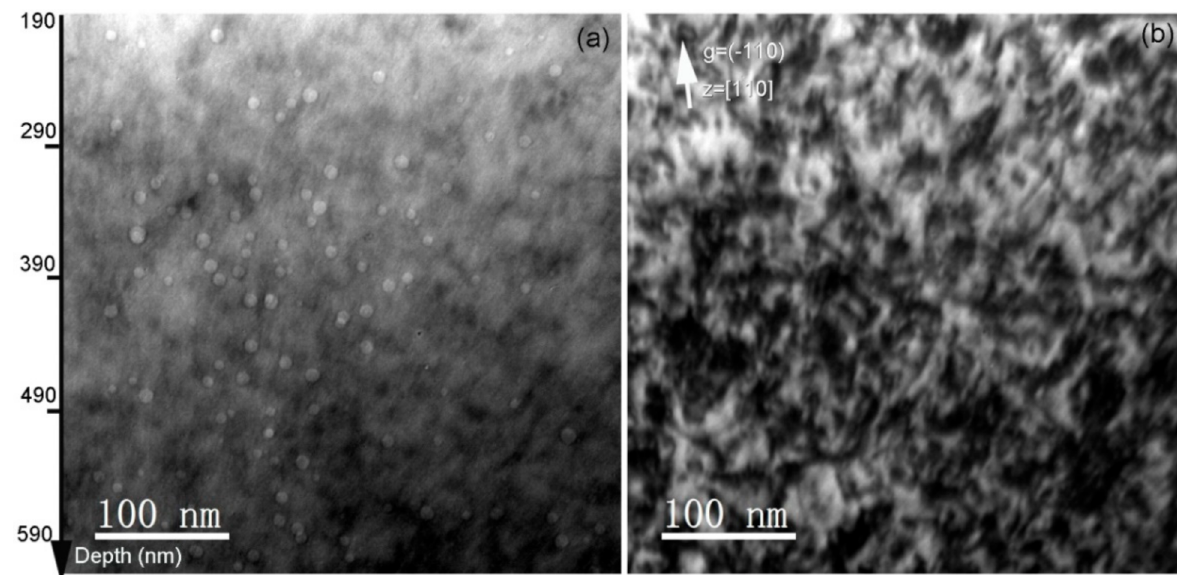
Figure 3. ( a ) Bright-field XTEM micrograph of irradiation-induced dislocation loops in the Fe and He co-irradiated SIMP steel to fluences of 1.65 × 10 16 Fe 3+ · cm − 2 and 4.5 × 10 15 He + · cm − 2 . Micrographs were taken near [110] zone axis under the kinematic condition, g = ( − 110), ( b ) Bright-field TEM micrograph of cavities formed in the Fe and He co-irradiated SIMP steel. The under-focused view with ∆ f = − 512 nm was performed to characterize cavity